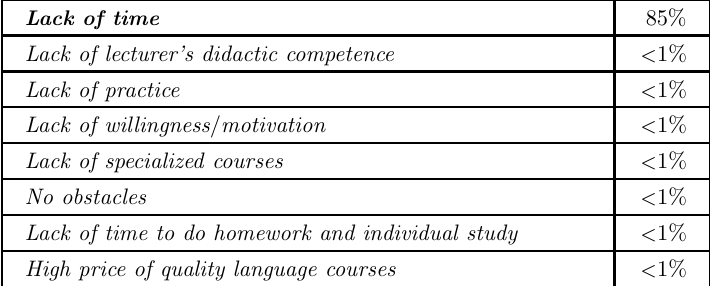
Obstacles to improve English faced by participants Lack of